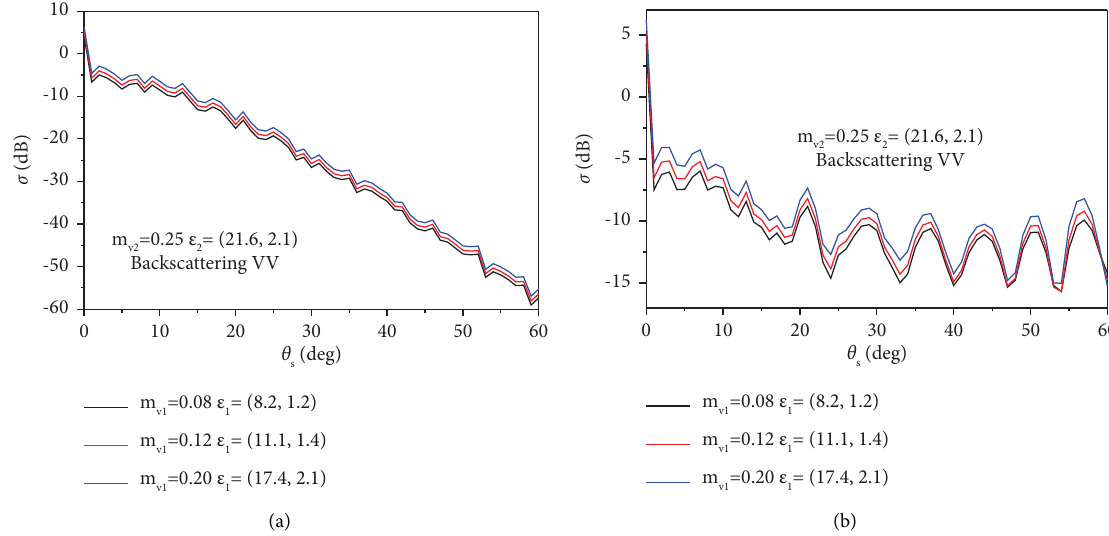
Figure 6: Backscattering for diferent soil moisture contents of the upper layer for (a) two-layered soil surfaces and (b) the composite